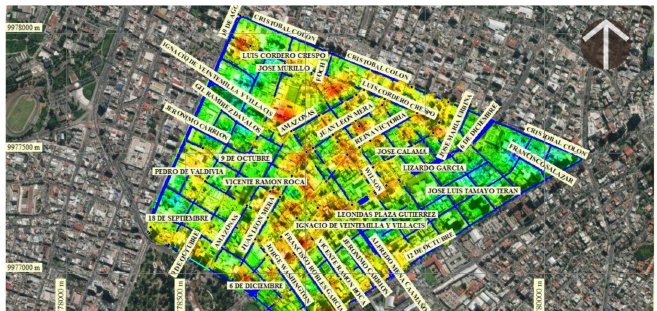
Figure 10. The integration of the information obtained by PS-INSAR and the Analysis of Spatial Syntax determined the existence of several constructed areas exposed to intense deformation-speed of displacement of the land very susceptible to an earthquake greater than 6–7 Mw (colors with tendency to red).